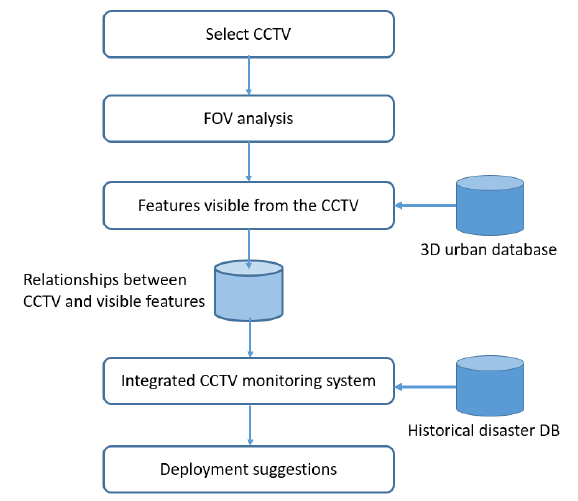
Figure 7 Workflow of the proposed